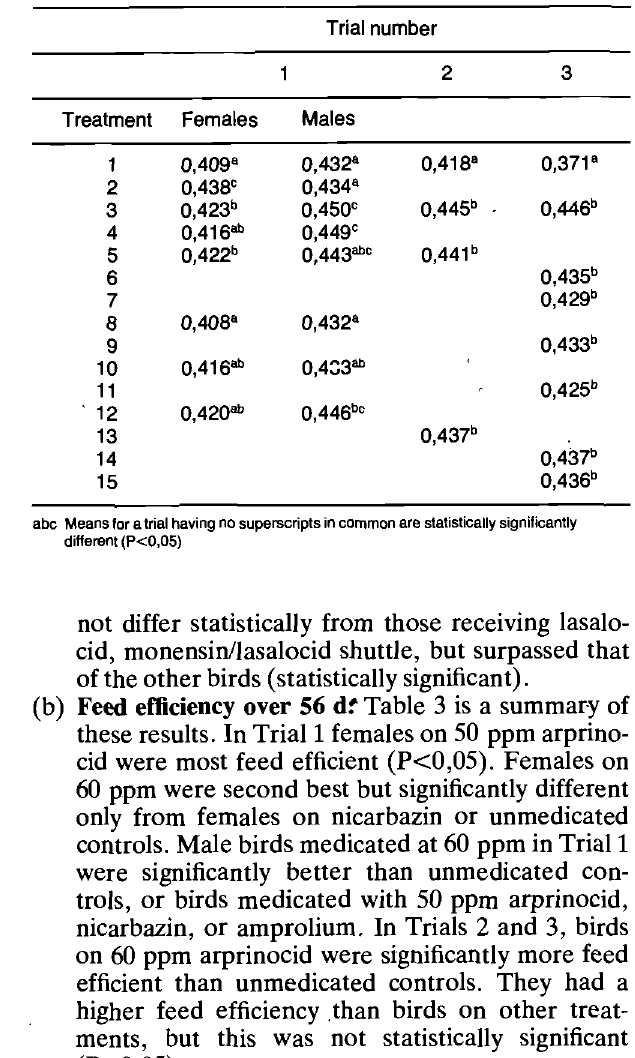
Table 2: MEAN LIVE MASS PER BIRD AT 56 d Trial number 2 3 Treatment